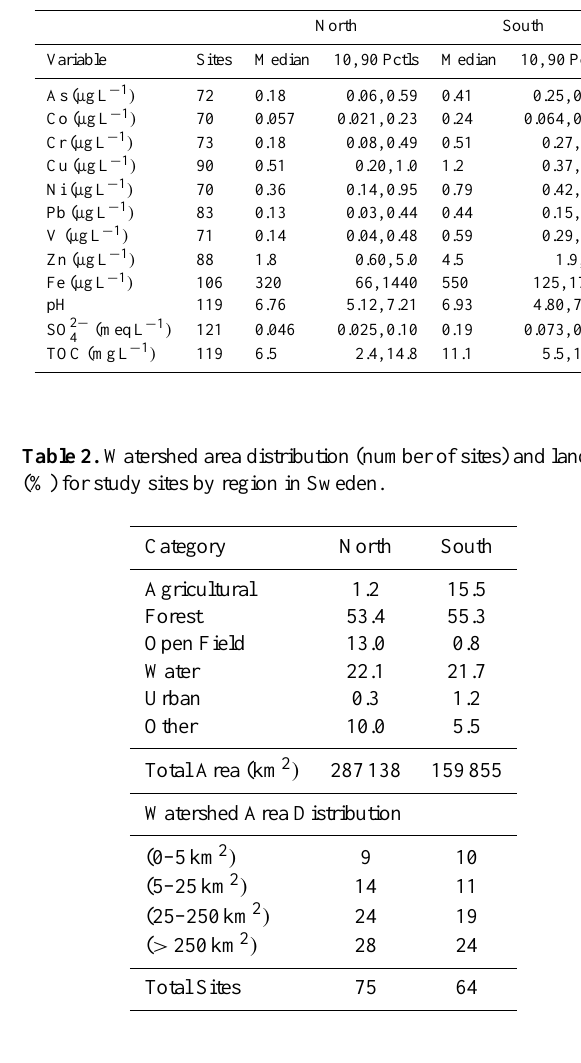
Table 1. List of variables and associated medians with 10th and 90th percentiles (Pctls) by region.